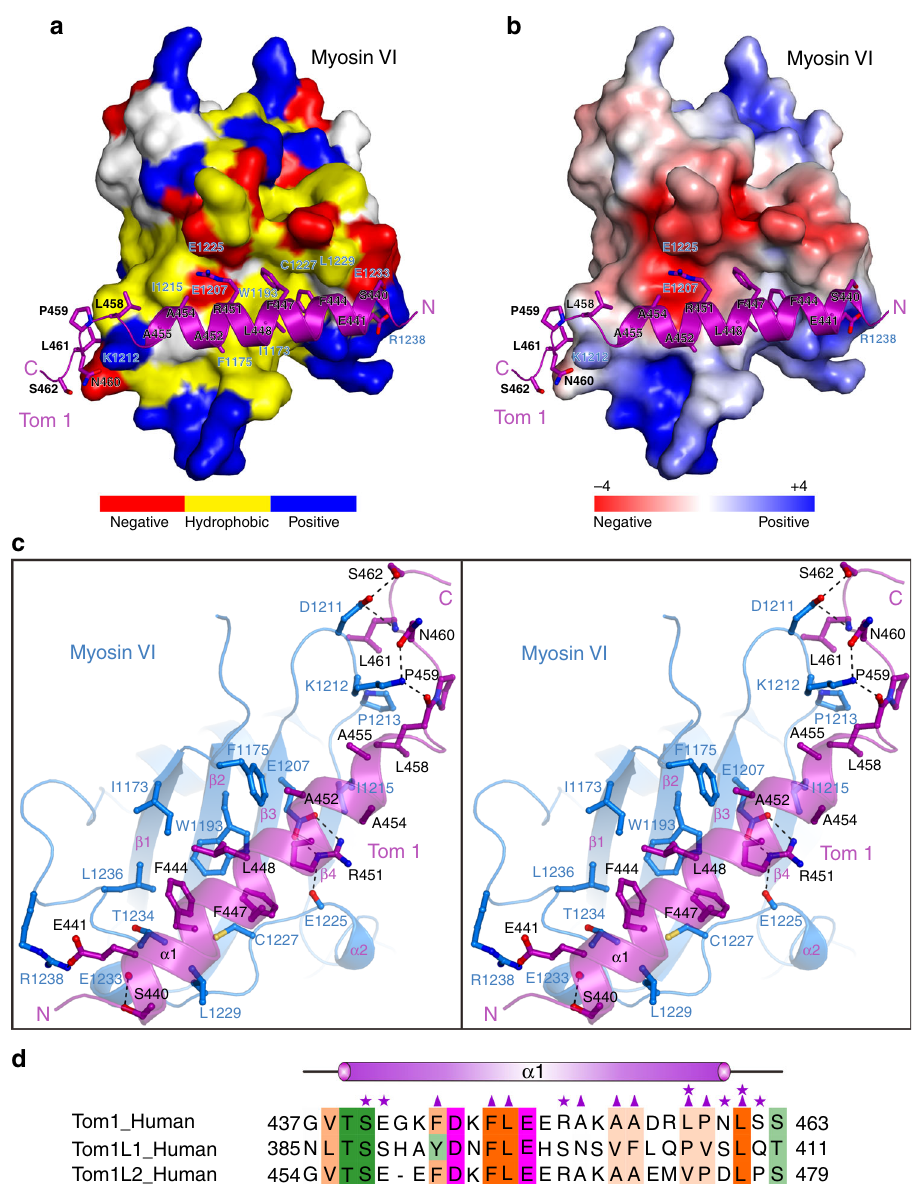
Fig. 3 The molecular interface of Myosin VI and Tom1 complex. a The combined surface representation and the ribbon-stick model showing the hydrophobic binding interface between the C-terminal CBD of Myosin VI and Tom1 MBM. In this presentation, the C-terminal CBD of Myosin VI is shown in the surface model and Tom1 MBM in the ribbon-stick model. Particularly, in the surface model of the C-terminal CBD of Myosin VI, the hydrophobic amino acid residues are drawn in yellow, the positively charged residues in blue, the negatively charged residues in red, and the uncharged polar residues in gray. b The combined surface charge representation and the ribbon-stick model showing the charge-charge interactions between the C-terminal CBD of Myosin VI and Tom1 MBM. c Stereo view of the ribbon-stick model showing the detailed interactions between the C-terminal CBD of Myosin VI and Tom1 MBM. The hydrogen bonds and salt bridges involved in the binding are shown as dotted lines. d Structure-based sequence alignment of Tom1 MBM with the corresponding regions of TomL1 and TomL2. In this structure-based sequence alignment, the conserved hydrophobic residues, polar neutral residues, positively charged residues, and negatively charged residues are colored in orange, green, blue, and magenta, respectively. Interface residues of Tom1 that are involved in the polar interactions and hydrophobic interactions with the C-terminal CBD of Myosin VI in the Myosin VI/Tom1 complex are further labeled with magenta stars and magenta triangles,